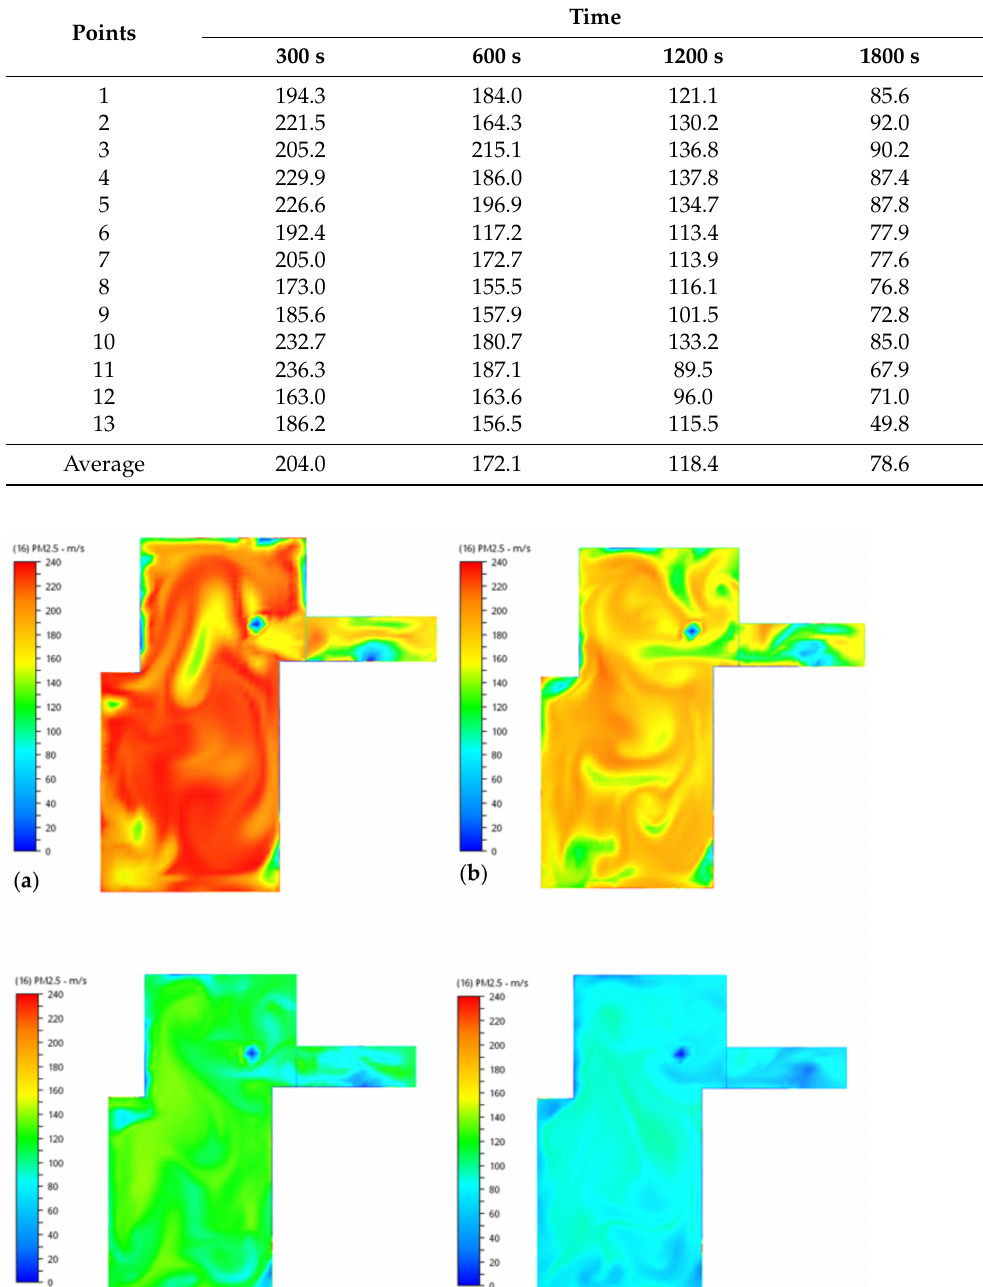
Table 5. Quantitative results of the best location (unit is µ g/m 3 ).